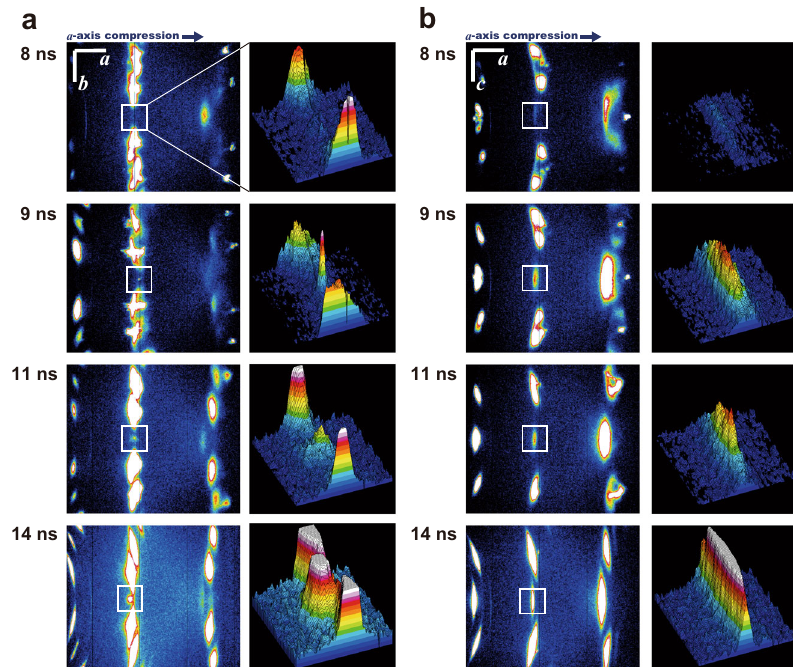
Fig. 3 XFEL diffraction images showing time evolution of g = 300 re fl ection from the polypropylene-olivine layered target. Crystallographic orientations ( a , b , and c ) are approximately shown for readability together with the direction for a -axis compression. These axes are not necessarily exactly located on the detector plane. White squares show the position of g = 300, and their magni fi ed views were separately shown at the right of the images. a Series images along the b direction, indicating that the g = 300 re fl ection was not deformed. b Series images along the c direction, indicating that the g = 300 re fl ection was extensively deformed. Laue indices of the other re fl ections together with the images of wider area coverage are shown in Supplementary Fig.